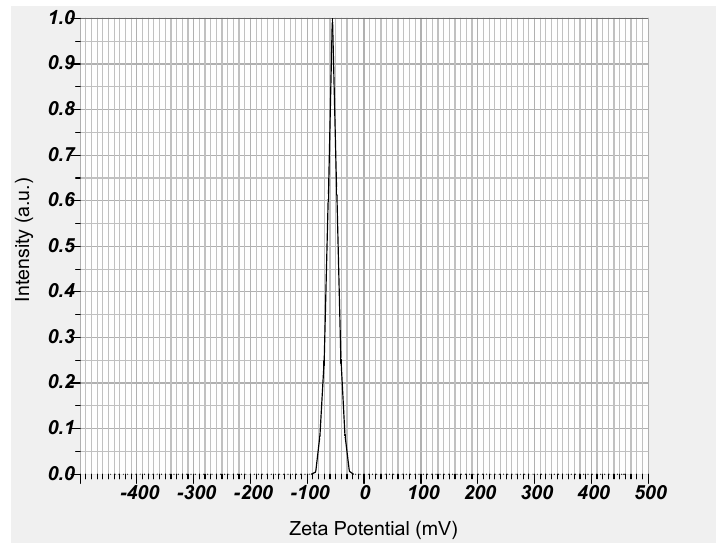
Figure 5. Zeta potential of NM-loaded micelle